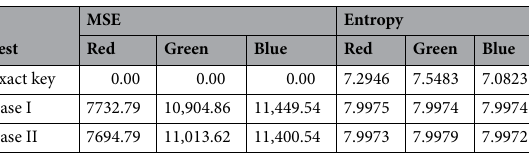
Table 11. Decryption results with different keys.